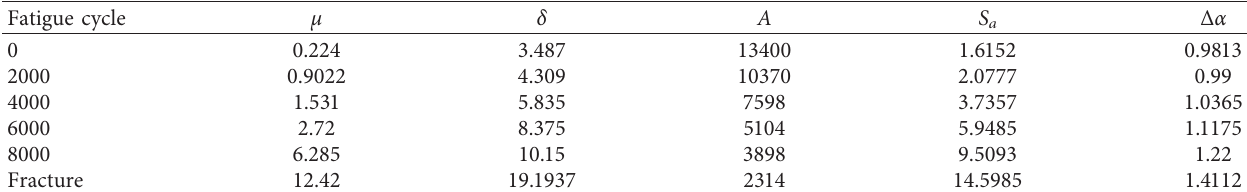
Table 2: Six sets of test data values for each damage